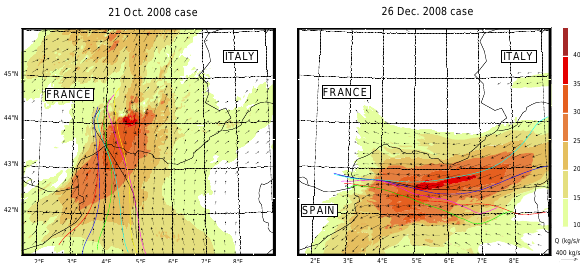
Fig. 11. HRA2.5 simulated water vapour flux Q integrated over the lowest 3000m (in kgs − 1 m − 2 , colour scale on the right of the figure, and arrows) and horizontal projection of the backward trajectories of some air parcels taken in the precipitating systems simulated by HRA2.5 for the 21 October 2008 case (left) and the 26 December 2008 case (right). The arrows are drawn every 10 grid points with a scale given by the length of the arrow at the bottom right of the figure. Arrows are displayed only when corresponding to values of integrated water vapour flux larger than 80kgs − 1 m − 2 . The backward trajectories are the same as in Figs. 7 and 9. They show the parcel trajectories from 09:00UTC till 19:00UTC for the 21 October 2008 case and from 05:00UTC till 15:00UTC for the 26 December 2008 case. The background of the trajectory figure is a snapshot of the integrated water vapour flux at 14:00UTC for the 21 October 2008 case and at 08:00UTC for the 26 December 2008